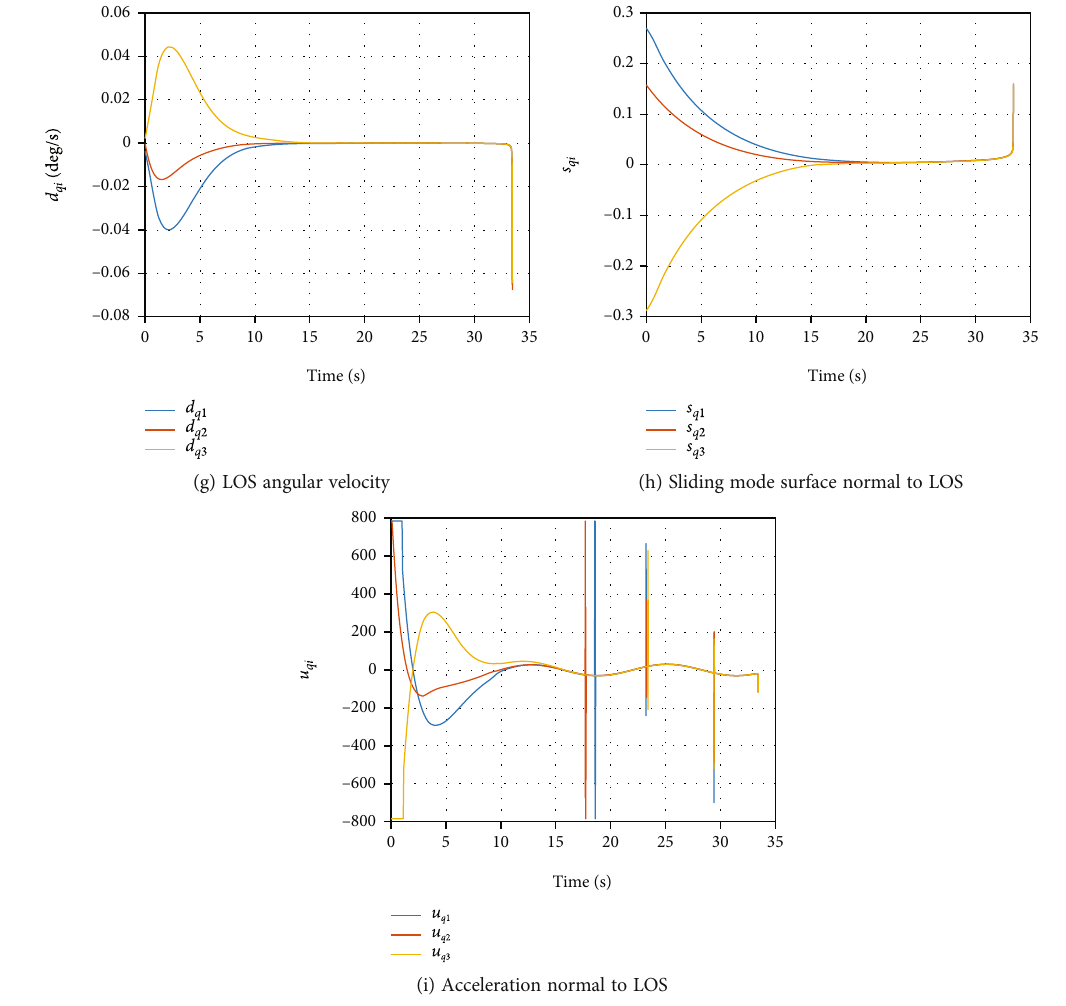
Figure 4: Response curves under the proposed algorithm for Case 1. Table 2: Miss distances and interception